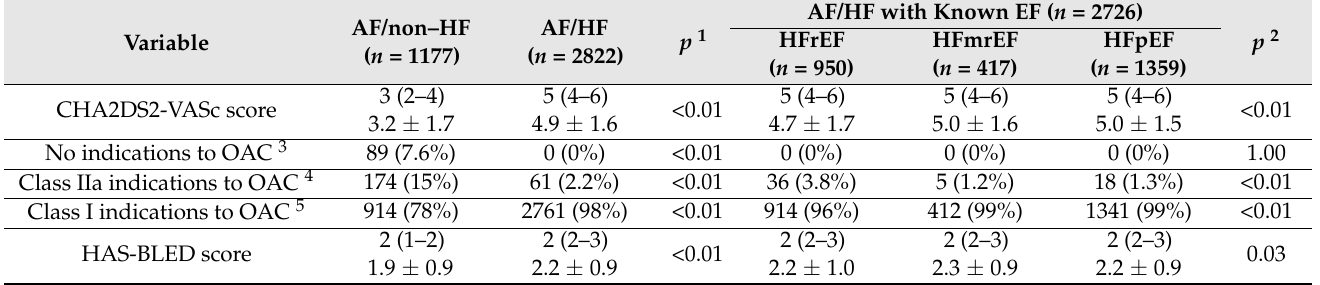
Table 2. Thromboembolic and bleeding risk of hospitalized atrial fibrillation patients depending on presence or absence of heart failure and its